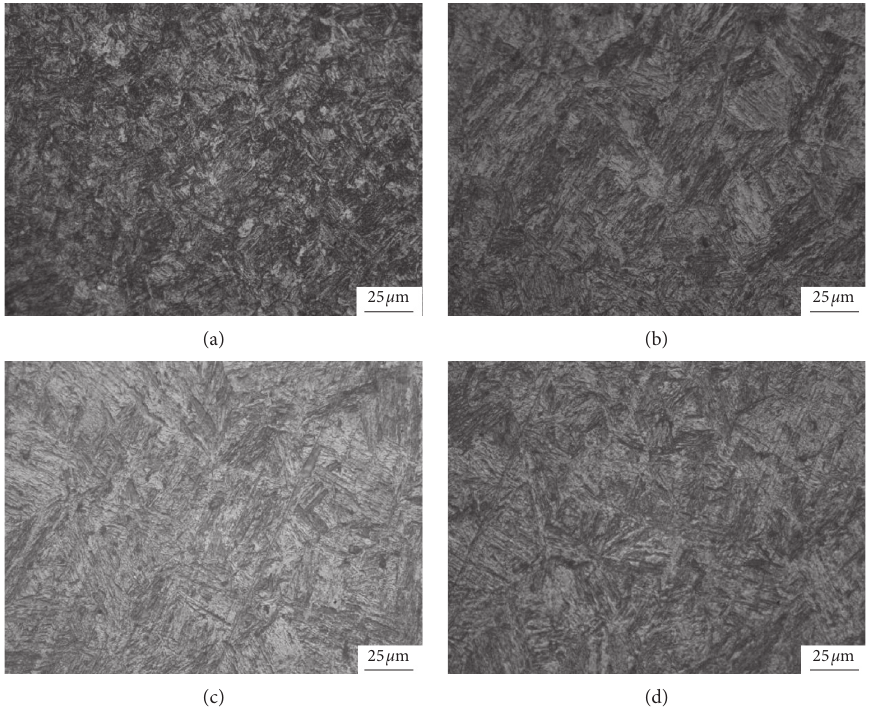
Figure 14: Microstructure of positions A, B, C, and D.